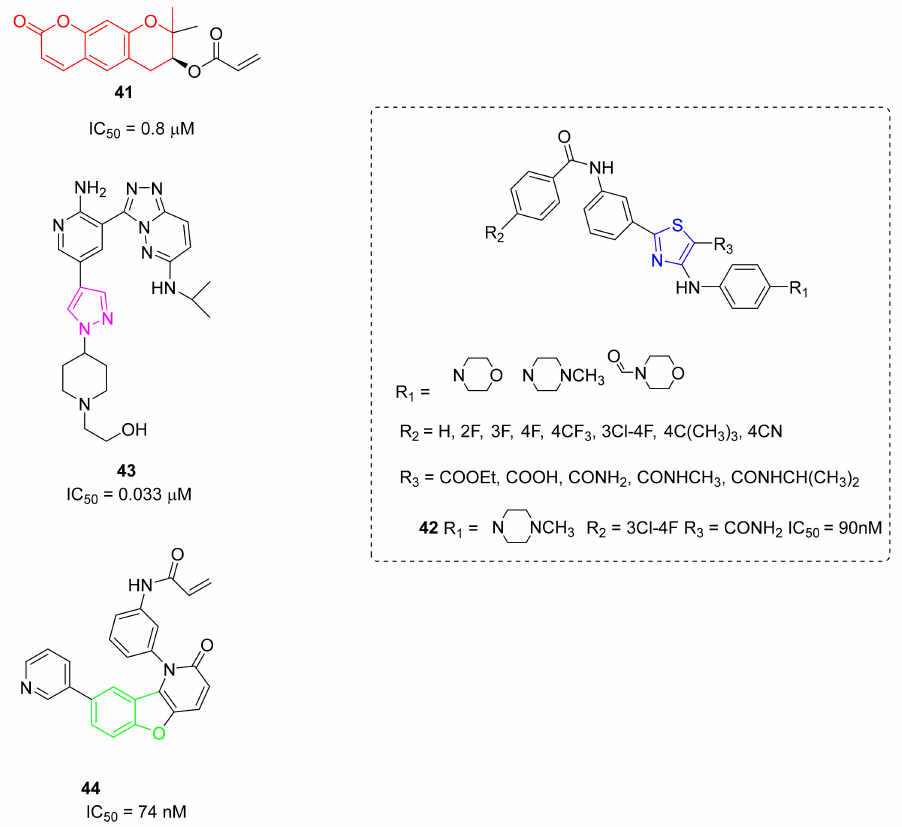
Figure 12. Miscellaneus